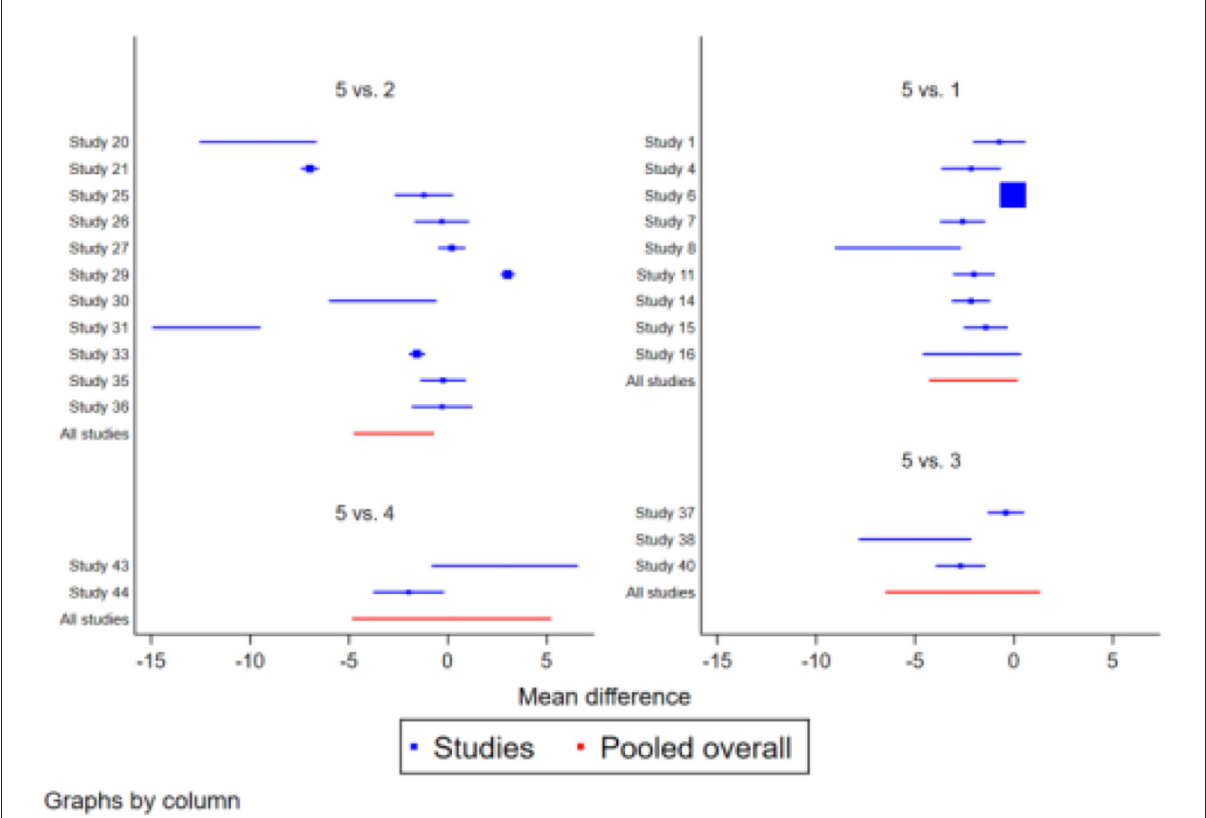
FIGURE5 Forest map of the effect of traditional Chinese physical exercise therapy on ECLSB of the elderly.